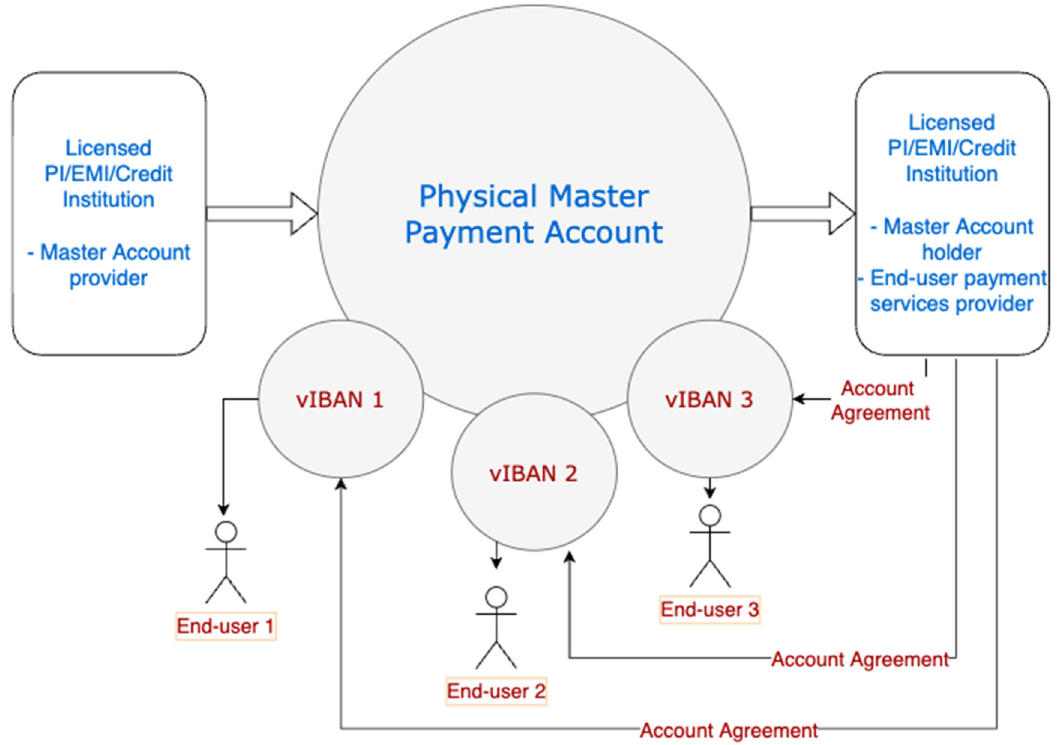
Figure 2. vIBANs. Figure 2.